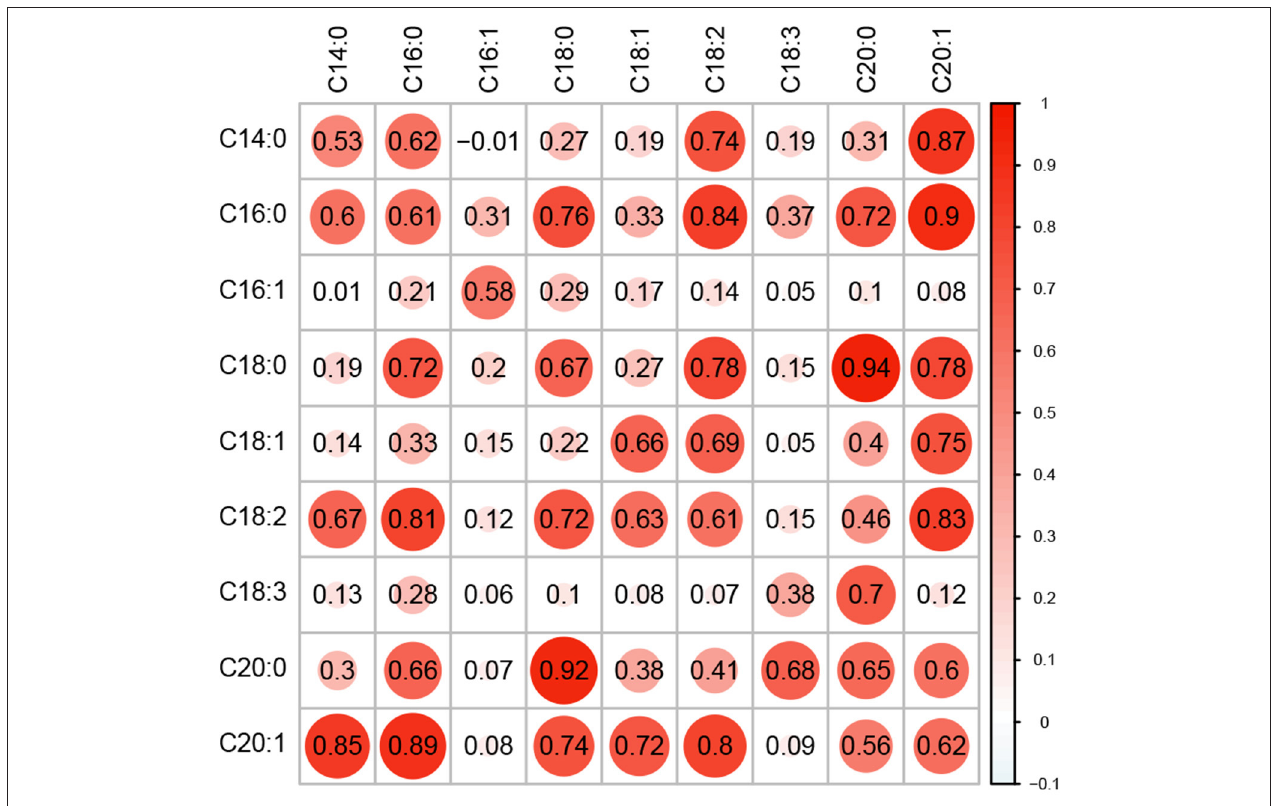
FIGURE 1 | Correlation and heritability for nine fatty acid traits. Genomic correlation between fatty acid phenotypes is shown in the upper triangle of the matrix, while the lower triangle shows the phenotypic correlations. Narrow-sense heritability estimates ( h 2 ) are provided along the diagonal. All values were estimated using a multi-trait BLUP model using phenotypes recorded in the Diversity Panel. The size of each circle is proportional to the magnitude of the estimate.